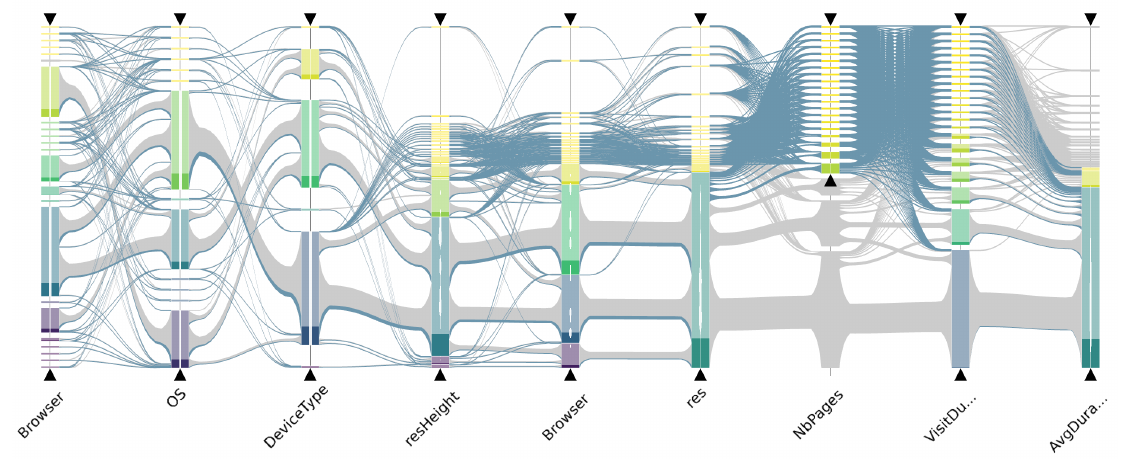
Figure 5. Two selection views on a C2C dataset described in the next section. Here, items are visiting session on a website. Selecting an aggregate (cluster or meta-link) triggers the highlight of the selected subset through all the displayed axes. The inner-cluster histograms are also updated according to the selection. ( a ) Selection of the smartphone category (on DeviceType ); ( b ) Selection of the higher range of values (between 37 and 300) on the NbPages axis which relates to the number of visited